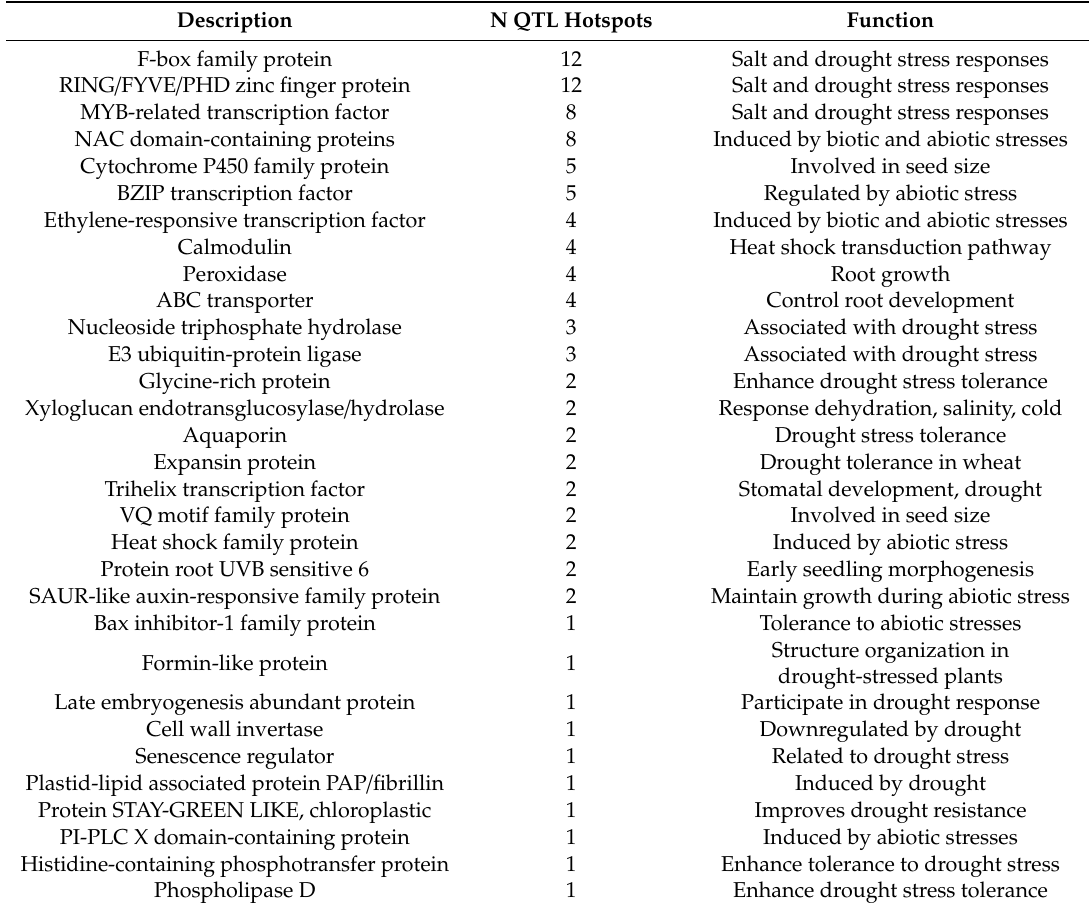
Table 8. Selected gene model